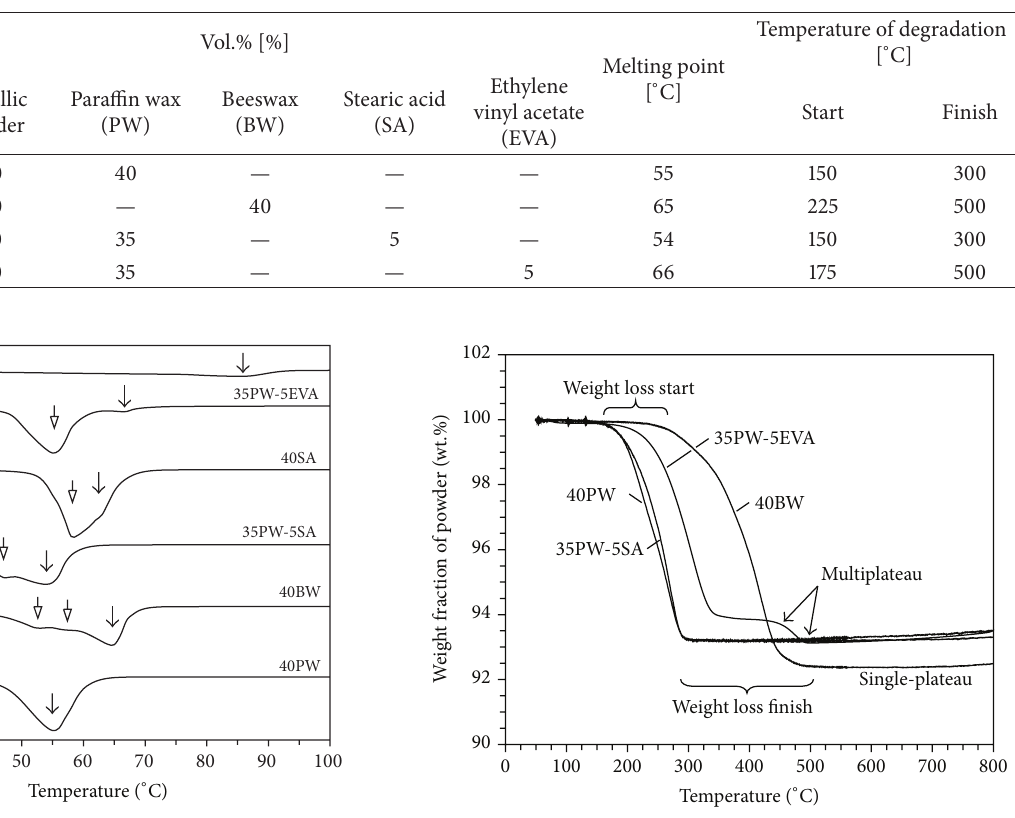
Table 1: Nominal volume fraction and melting temperatures of the binders used for the feedstocks.